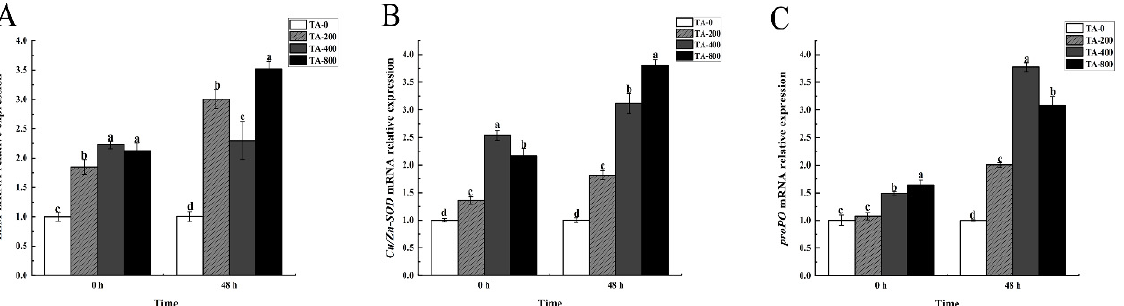
Figure 6. Immune gene expression levels in the hepatopancreas of L. vannamei that were fed the control and TA diets for 56 days (0 h) before being exposed to ammonia stress for 48 h. ( A ) LZM mRNA expression; ( B ) Cu/Zn-SOD mRNA expression; ( C ) proPO mRNA expression. Vertical bars represent the mean values ± SD ( n = 3). Data marked with different letters were significantly different ( p < 0.05) among groups.